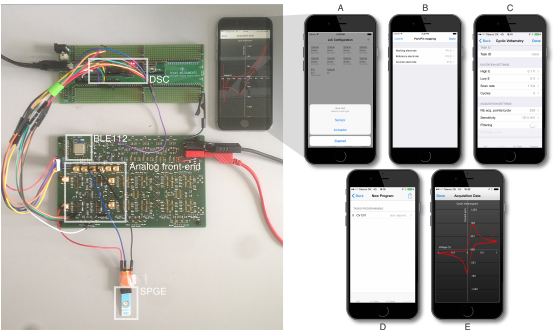
Figure 6. System hardware setup: The HWA materializes at this early development stage by a development board hosting the HWA CPU (TI C2000 TMS320F28377D DSC) interfaced to a